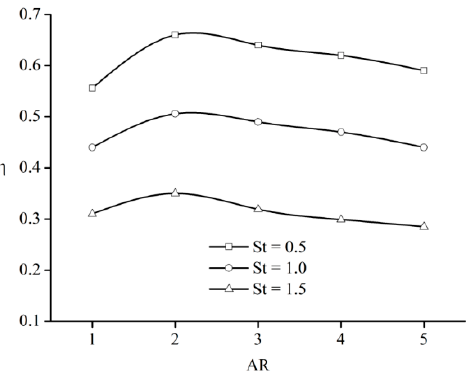
Figure 6. Propulsion efficiency of current AUG versus magnitude of AR at different St numbers.